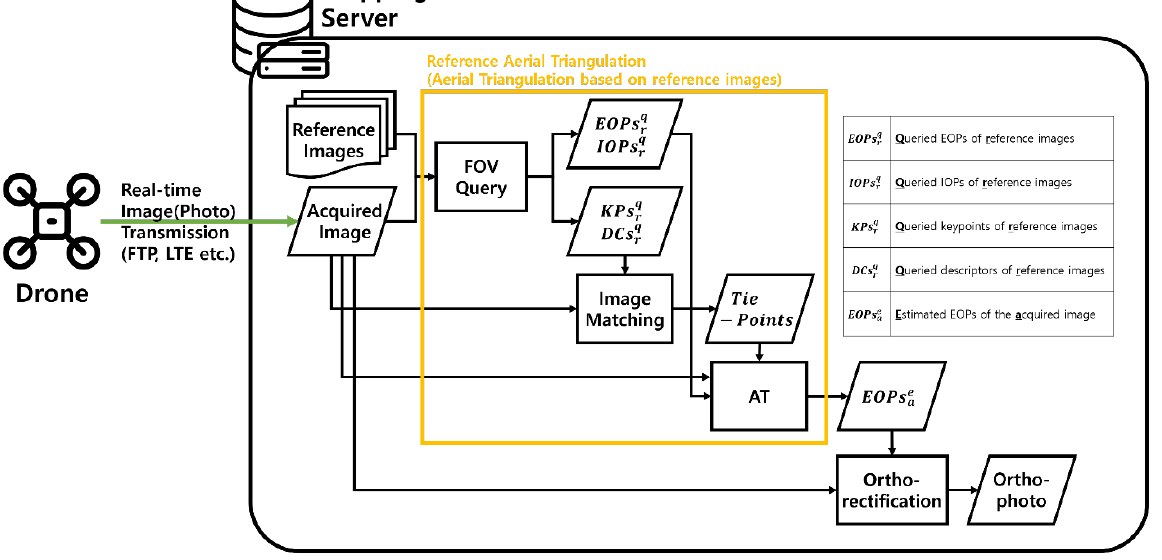
Figure 1. The architecture of proposed